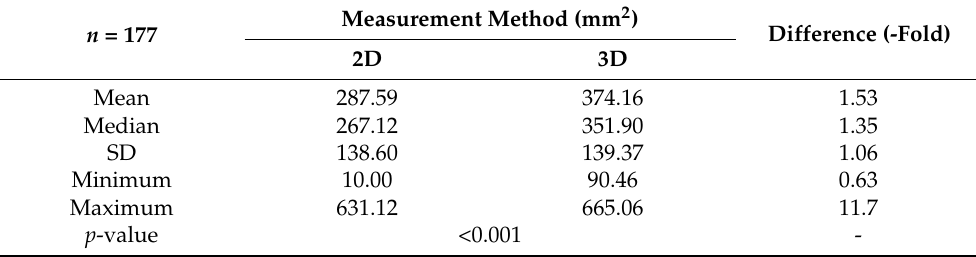
Table 3. Processing times of the 2D- and 3D-based measurement methods of orbital floor defect areas. n =